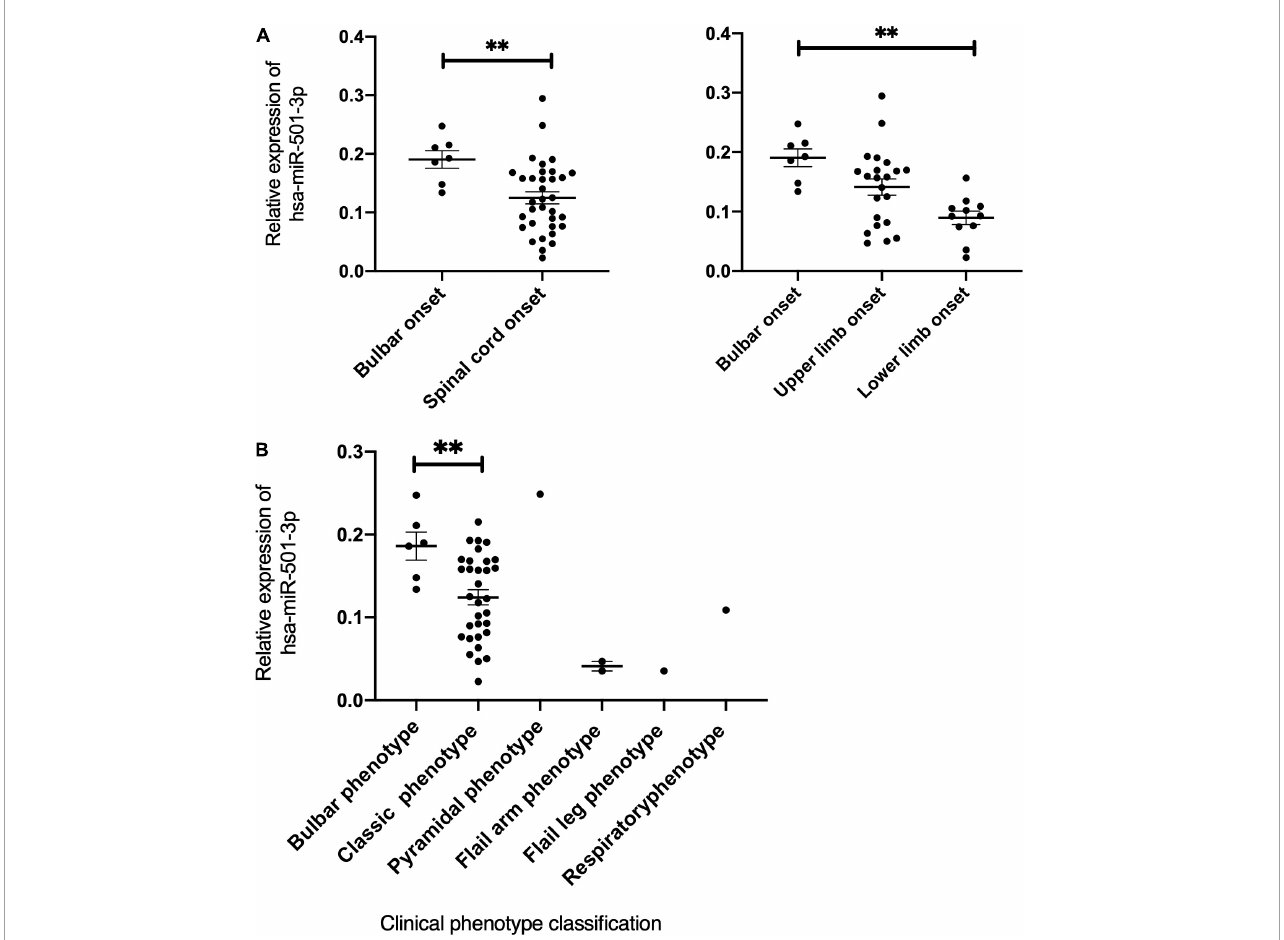
FIGURE4 The expression of has-miR-501-3p and the correlation with clinical characteristics in patients with ALS. (A) The relationship of the relative expression of hsa-miR-501-3p and the onset site. Hsa-miR-501-3p was found to be specifically increased in patients whose initial symptoms presenting at bulbar-onset ( p = 0.0098). Compared to lower limb onset, hsa-miR-501-3p was increased significantly in bulbar-onset of patients with ALS ( p = 0.0027) and there was no significance between upper limb onset and lower limb onset groups. (B) The relationship of the relative expression of hsa-miR-501-3p and the clinical phenotype classification. ∗∗ p <